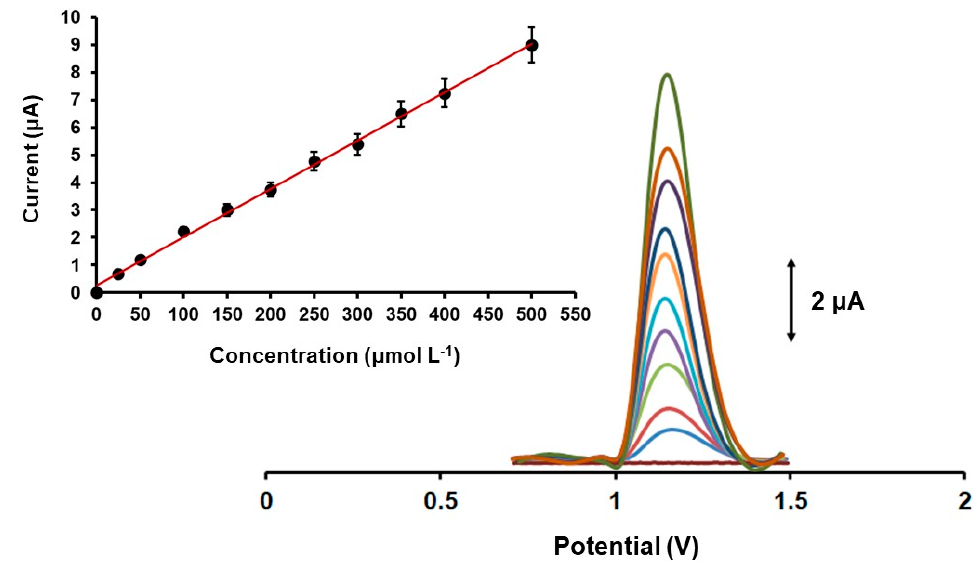
Figure 7. Baseline-corrected DPV responses of GLU concentrations in the range 0–500 µ mol L − 1 (from down to up: 0, 25, 50, 100, 150, 200, 250, 300, 350, 400, 500 µ mol L –1 GLU) in 0.1 mol L –1 PB (pH 4) applying a reduction potential at − 1.4 V for 360 s. Each point in the calibration plots is the mean value ± SD ( n = 3).